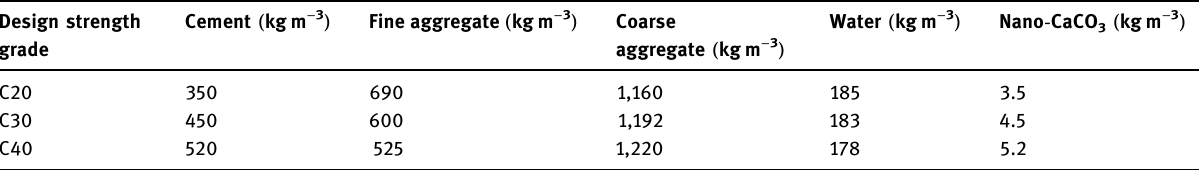
Table 3: Mix proportions of the nano - CaCO 3 concrete Design strength